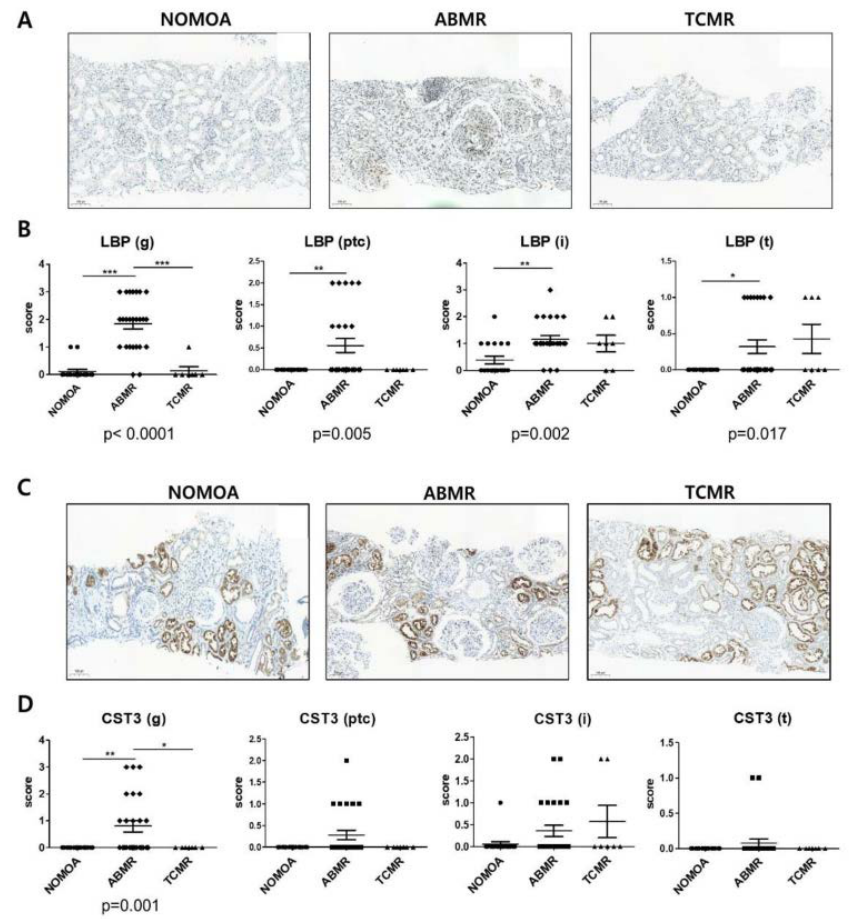
Figure 5. Validation for biomarker candidates in allograft tissues. ( A ) Immunohistochemistry (IHC) staining for LBP (visible as intense brown deposits) in representative biopsy specimens from the NOMOA ( n = 18), ABMR ( n = 25), and TCMR ( n = 7) groups. ( B ) Expression of LBP corresponding to histopathologic scores in glomerulus (g), peritubular capillary (ptc), interstitium (i), and tubules (t) ( × 100 magnification). ( C ) IHC staining for CST3 (visible as intense brown deposits) in representative biopsy samples from the NOMOA, ABMR, and TCMR groups. ( D ) Expression of CST3 corresponding to histopathologic scores in g, ptc, i, and t ( × 100 magnification). Error bars indicate mean ± SEM. Kruskal–Wallis one-way ANOVA p values are indicated for each protein. Dunn’s Multiple Compari- son test post hoc test significance values are indicated as * p < 0.05 ** p < 0.01 *** p < 0.001. 95% CI, 95% confidence interval. ABMR, antibody-mediated rejection; NOMOA, no major abnormality; TCMR, T-cell-mediated rejection; CST3, Cystatin-C; LBP, lipopolysaccharide-binding protein; g, glomeruli; ptc, peritubular capillaries; i, interstitium; t, tubules.3.6. Correlation between Banff lesion scores and biomarker scores of